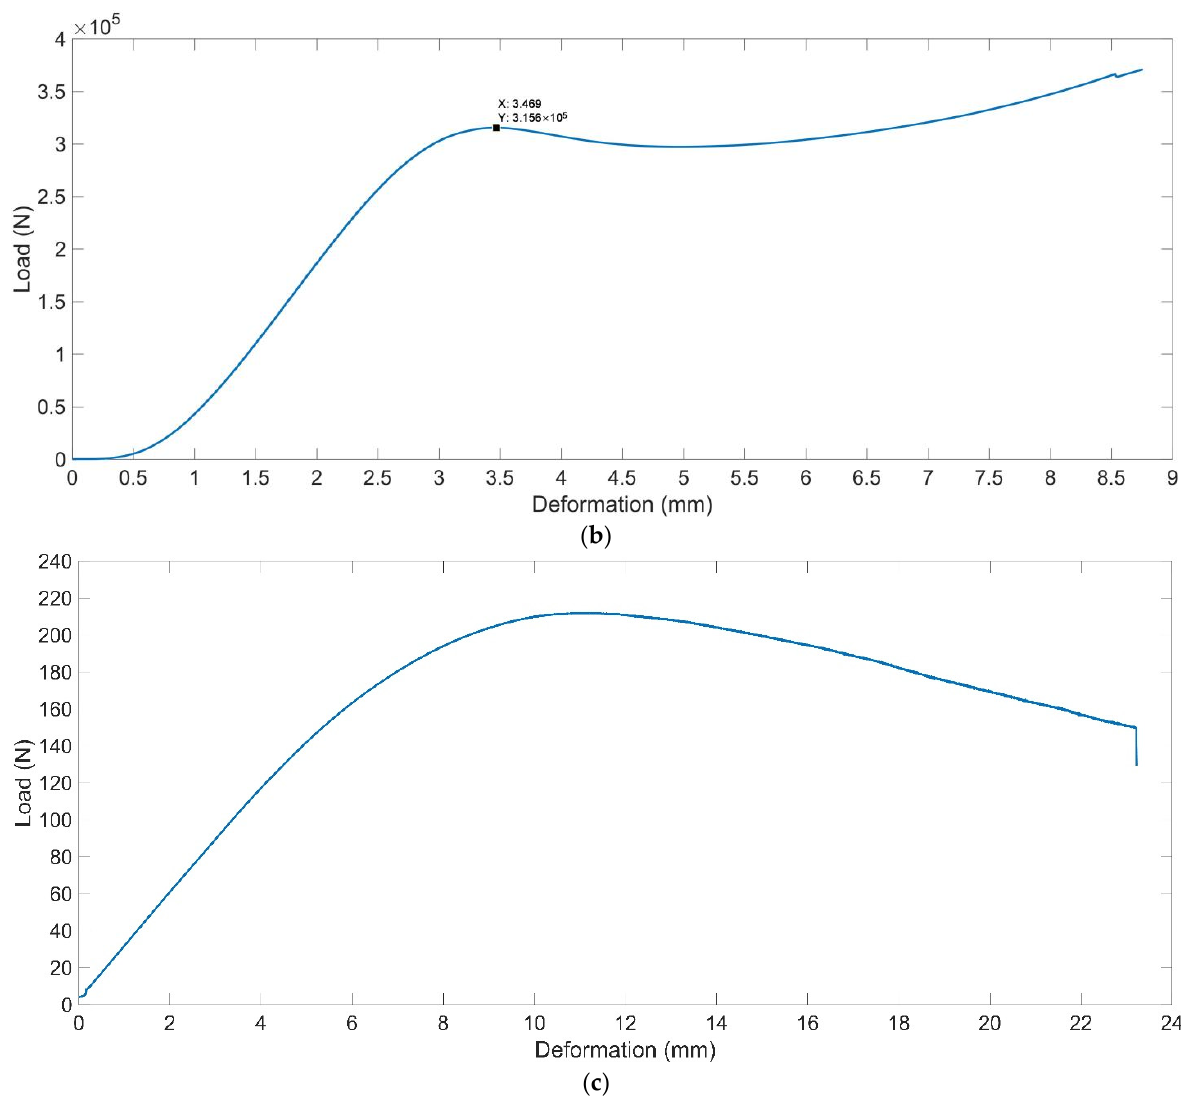
Figure 6. Cross-sectional experimental results of the mechanical properties of the prepared resin samples. ( a ) The tensile strength; ( b ) the compressive strength; ( c ) the flexural modulus. Based on the experimental data obtained in the detection process, the mechanical properties of the detected resin samples with different printing orientations were calculated through Equations (1) and (2) corresponding to tensile strength σ b and compressive strength σ bc , respectively. In Equation (1), F b is the maximum force during the yield stage and S o is the original middle sectional size 5 mm × 2 mm of the sample. For the cross-sectional experimental result of tensile strength in Figure 5a, it can be seen that the maximum force during the yield stage was 714.3 N, so the tensile strength σ b can be calculated as 71.43 MPa. In Equation (2), P is the maximum force during the compression process and A is the sectional size 50 mm × 50 mm of the sample in the compression direction. For the cross-sectional experimental result of compression strength in Figure 5b, it can be seen that the maximum force during the compression process was 3.156 × 10 5 N, so the compressive strength σ bc can be derived as 126.24 MPa.